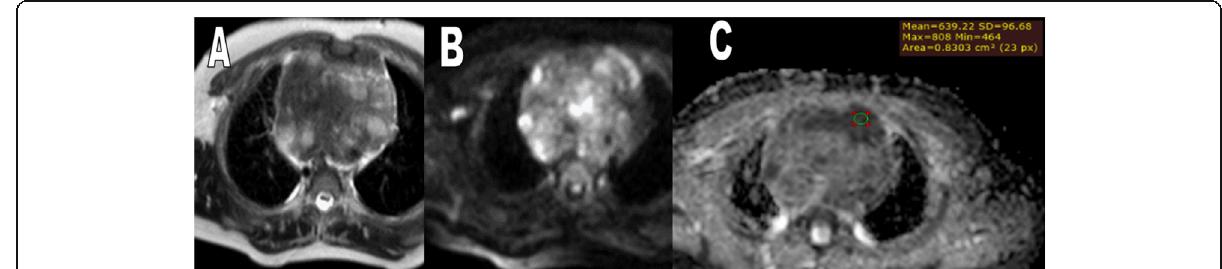
Fig. 4 Case of non-Hodgkin lymphoma. A 14-year-old male patient presenting with fatigue and loss of weight. MRI chest ( a ) axial T2WI, ( b ) axial